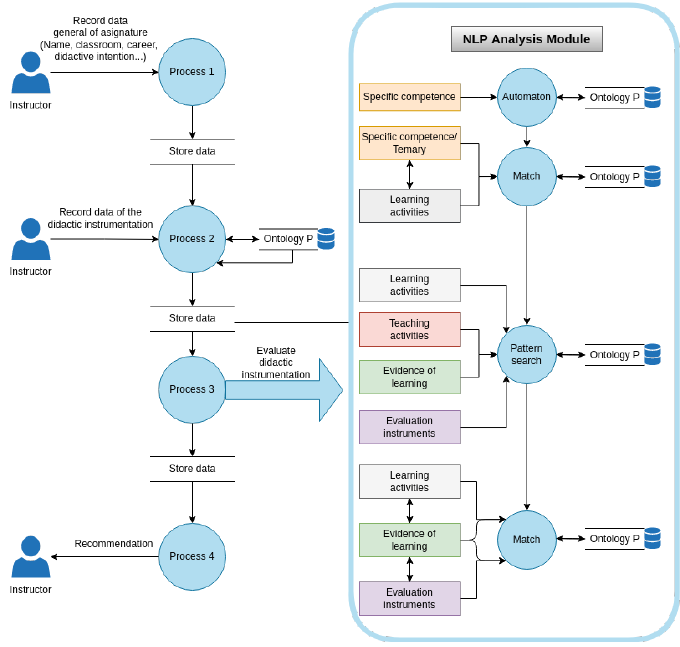
Figure 2. Flow diagram of the processes to evaluate didactic